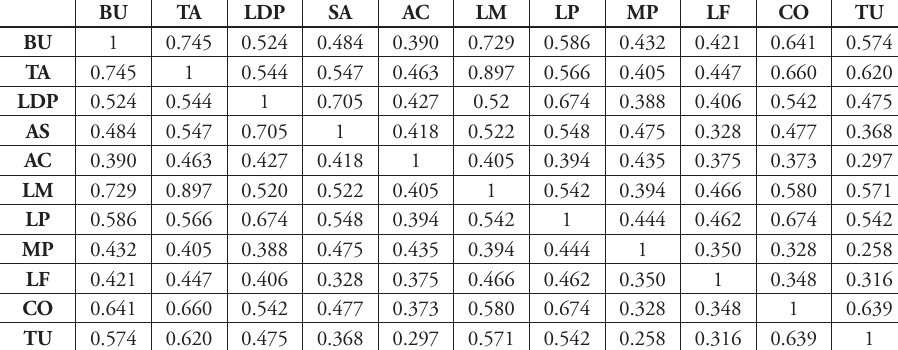
Table 2. Values of Dice Similarity Index (DSI) between ichthyocenoses recorded in limnic systems of Rio Grande do Sul Quaternary deposits. Legend: AC (Rio Grande coastal streams; Tagliani [1995]), BU (Tapes Butiazais ; Becker et al. [2007]), CO (Corrientes Stream; Volcan et al. [2012]), LDP (Lagoa do Peixe; Loebmann and Vieira [2005]), LF (Lagoa Fortaleza; Schifino et al. [2004]), LM (Lagoa Mangueira; Artioli et al. [2009]), LP (Lagoa Pequena marginal marshes; present study), MP (peat forest; Quintela et al. [2007]), SA (Cassino coastal streams; Bastos et al. [2013]), TA (Taim wetland; Garcia et al. [2006]), TU (Turuçu River basin; Burns et al.